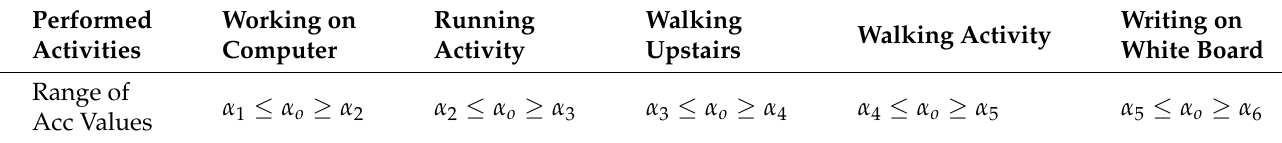
Table 3. Performed activities and range of accelerated